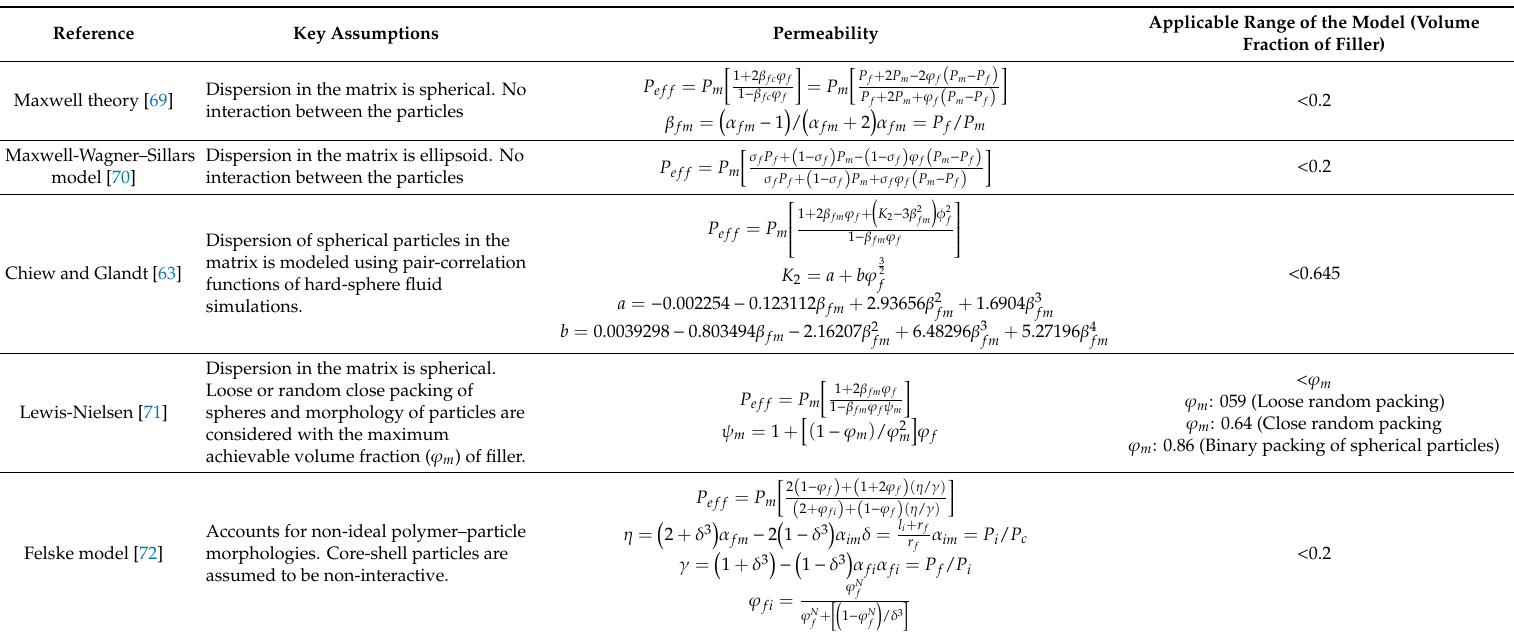
Table 2. Effective medium theory-based models.